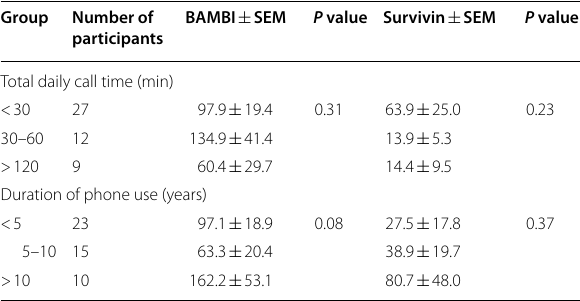
Fig. 1. Melting curves have been generated to confirm the specificity of the RT-PCR reactions (Fig. 2).